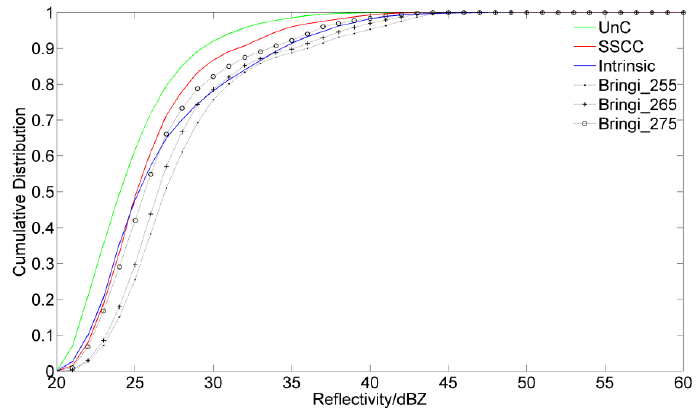
Figure 22. Cumulative distribution of reflectivity with different initial phases for the stratiform rain.